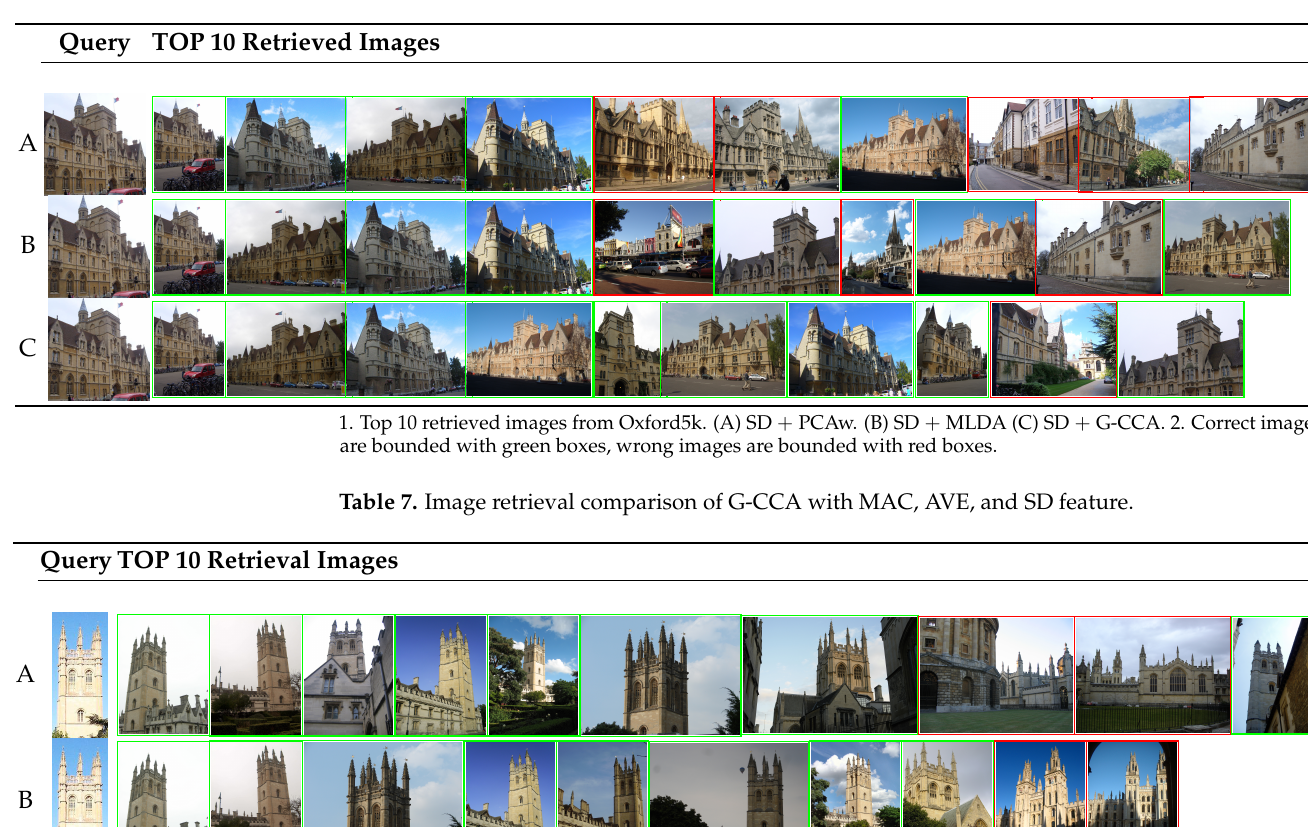
Table 6. Image retrieval comparison of PCAw, MLDA, and G-CCA.